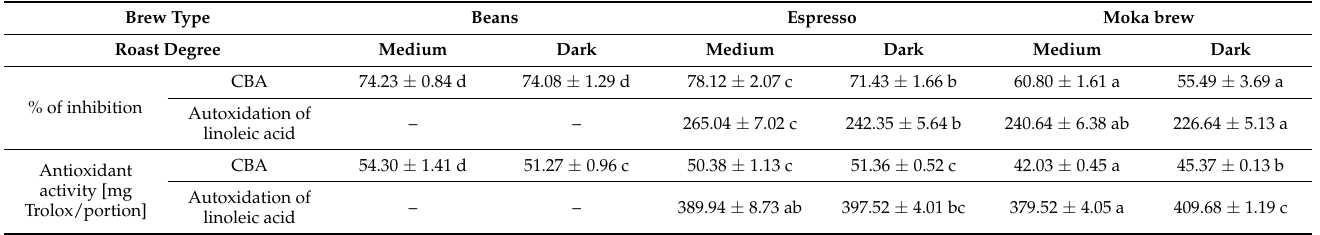
Table 4. Content of phenolic compounds and antioxidant activity measured by HAT-based